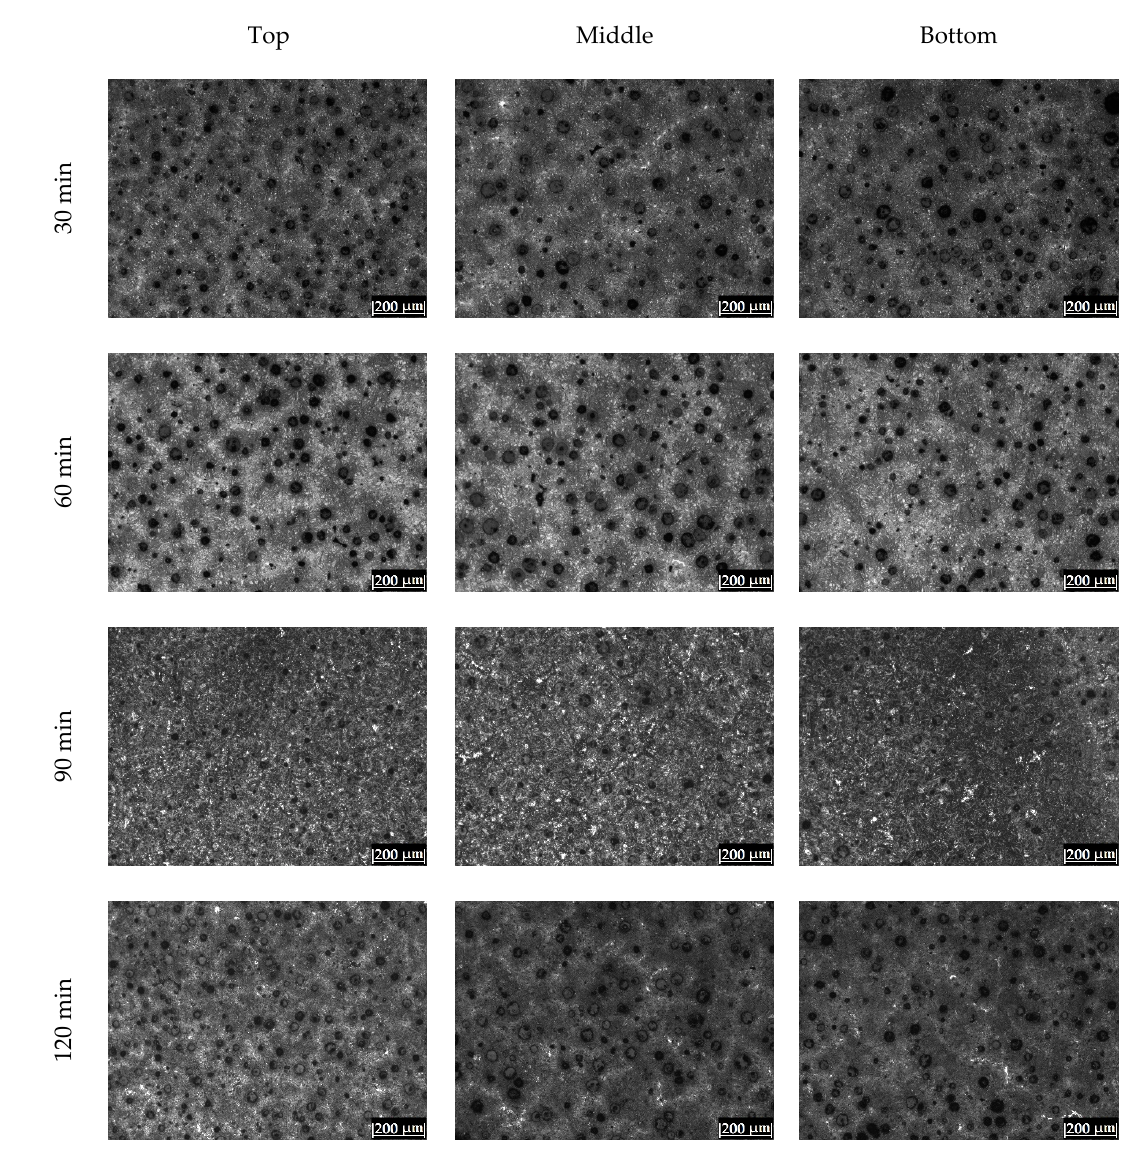
Figure A2. Microstructural evolution for the CADI-0.2Cr-265 sample at the austempering times of 30, 60, 90, and 120 min for the three regions analyzed.